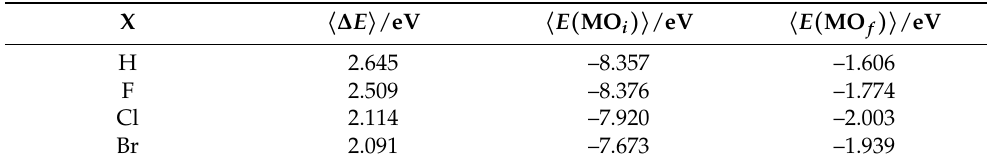
Figure 9. Distribution of the energy of the MOs involved in the excitation that gives rise to S 1 taken from the snapshots of the 30 ns QM/MM molecular dynamics simulation, where the solute is described using DFTB. MO i (left) denotes the orbital where the excitation starts and MO f (right) the orbital where the excitation ends. Table 3. Average excitation energies, average energies of the HOMO and of the LUMO involved in the excited S 1 state in the 30 ns DFTB/MM MD